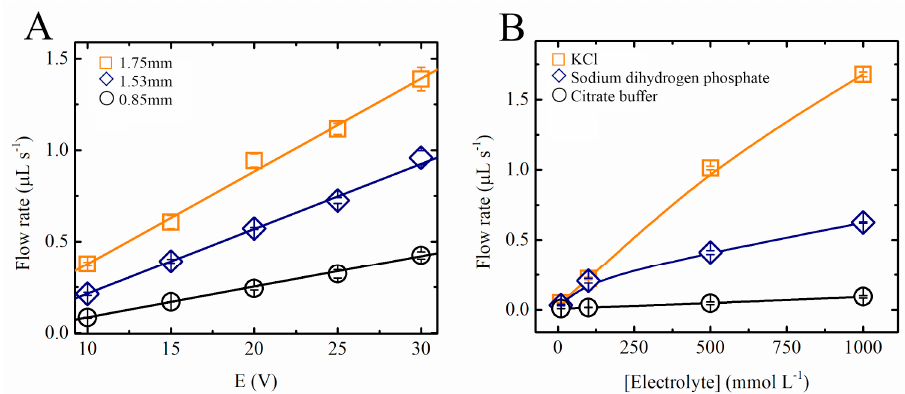
Figure 3. Study of the fluid movement on a single MHD pump (see Figure 1): ( A ) Flow rate as a function of electrical potentials applied for different channel widths using 0.5 mol L − 1 NaH 2 PO 4 as electrolyte. ( B ) Flow rate as a function of the concentration of the electrolyte for different ionic compositions using a fixed electrical potential and channel width of 15 V and 1.53 mm, respectively.